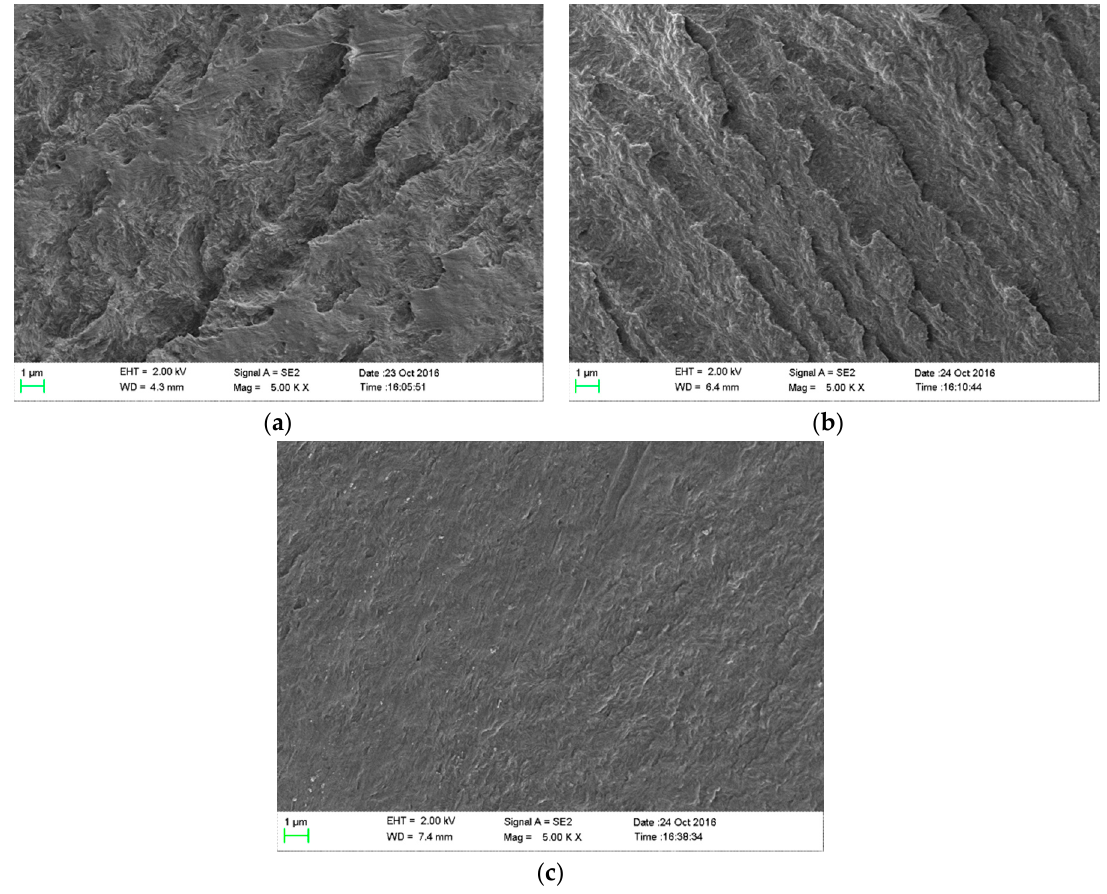
Figure 1. A sectional morphology graph of neat low-density polyethylene (LDPE) and 1 wt %- nanocomposites with an aging time of 77 days. ( a ) Scanning electron microscopy (SEM) image of neat LDPE; ( b ) SEM image of LDPE/SiO 2 nanocomposites; ( c ) SEM image of LDPE/MgO nanocomposites.